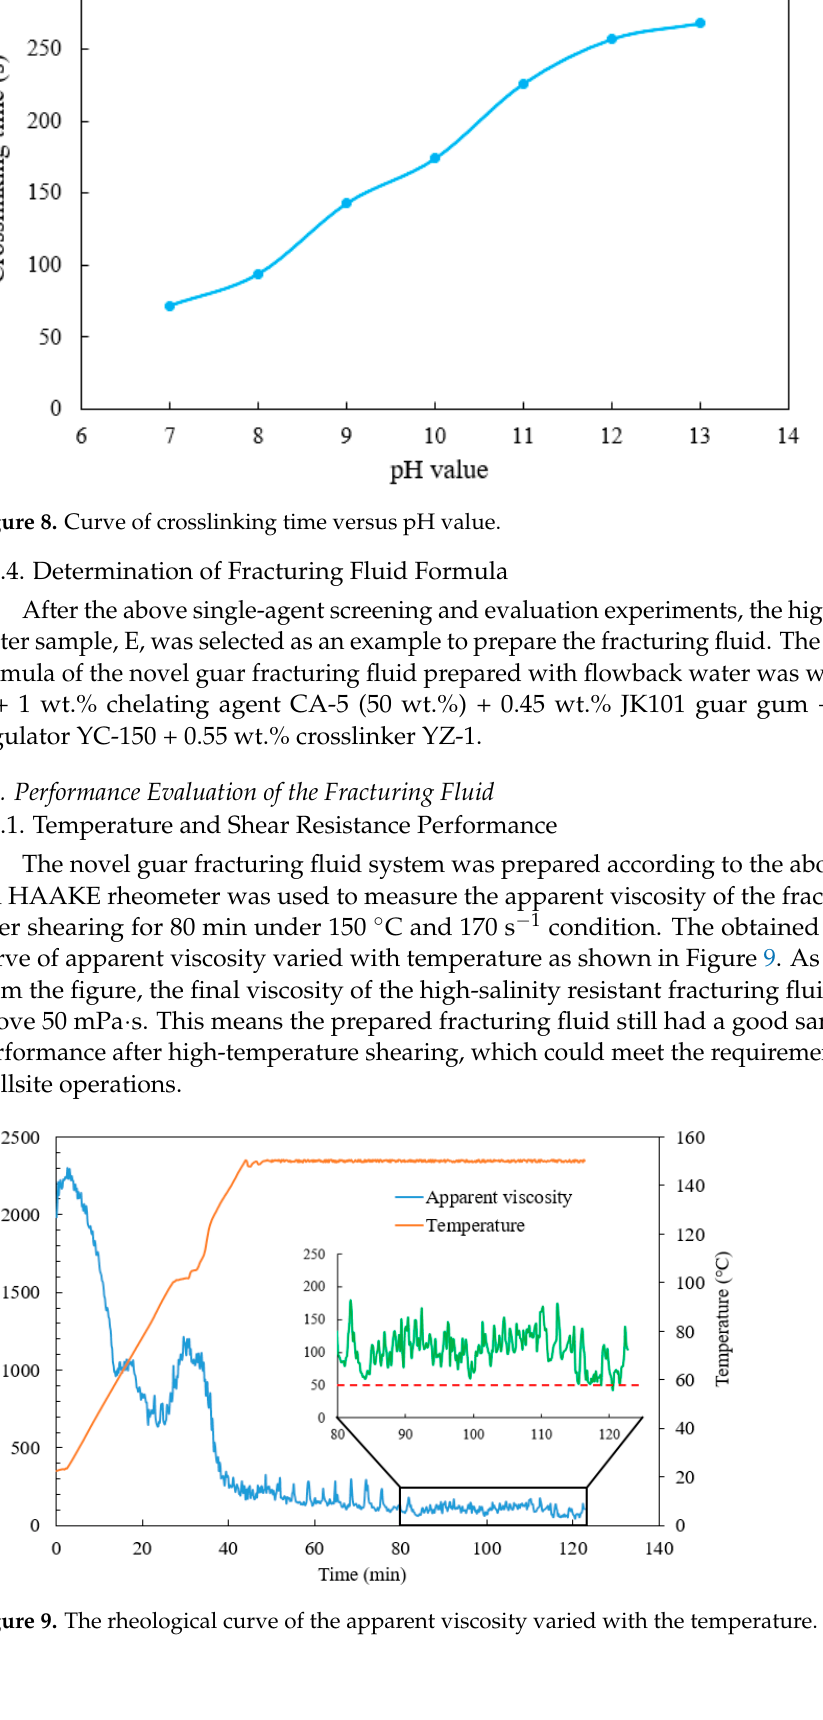
Figure 8. Curve of crosslinking time versus pH value.